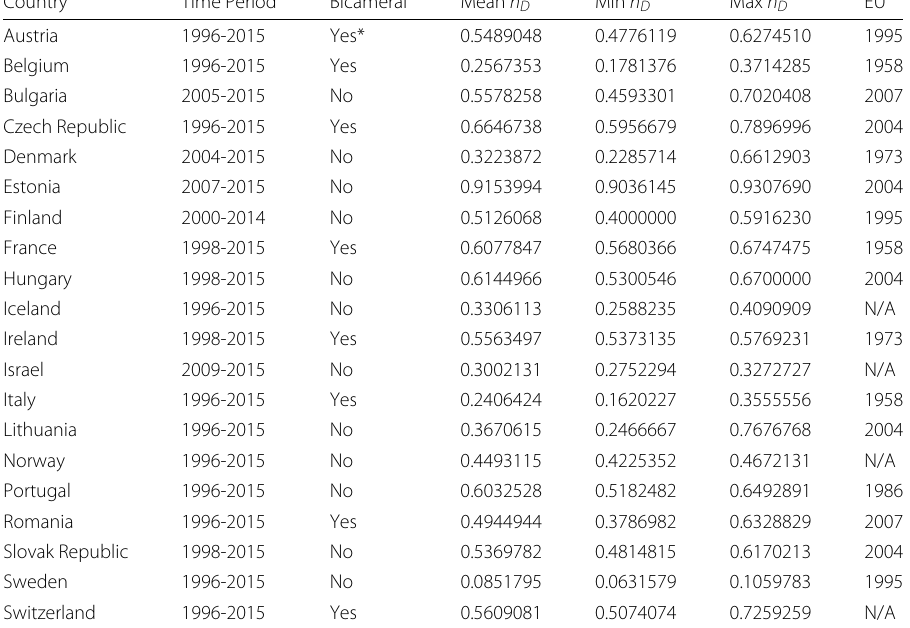
Table 2 Summary statistics